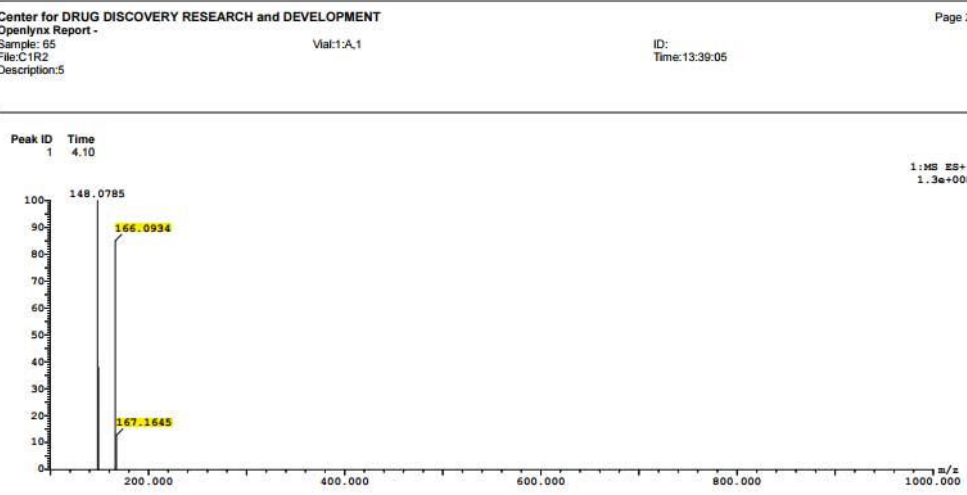
Figure 12. First mass for isolated AS2 peak 1 at retention time 4.1min with major molecular ion [M+H] + 166.093.